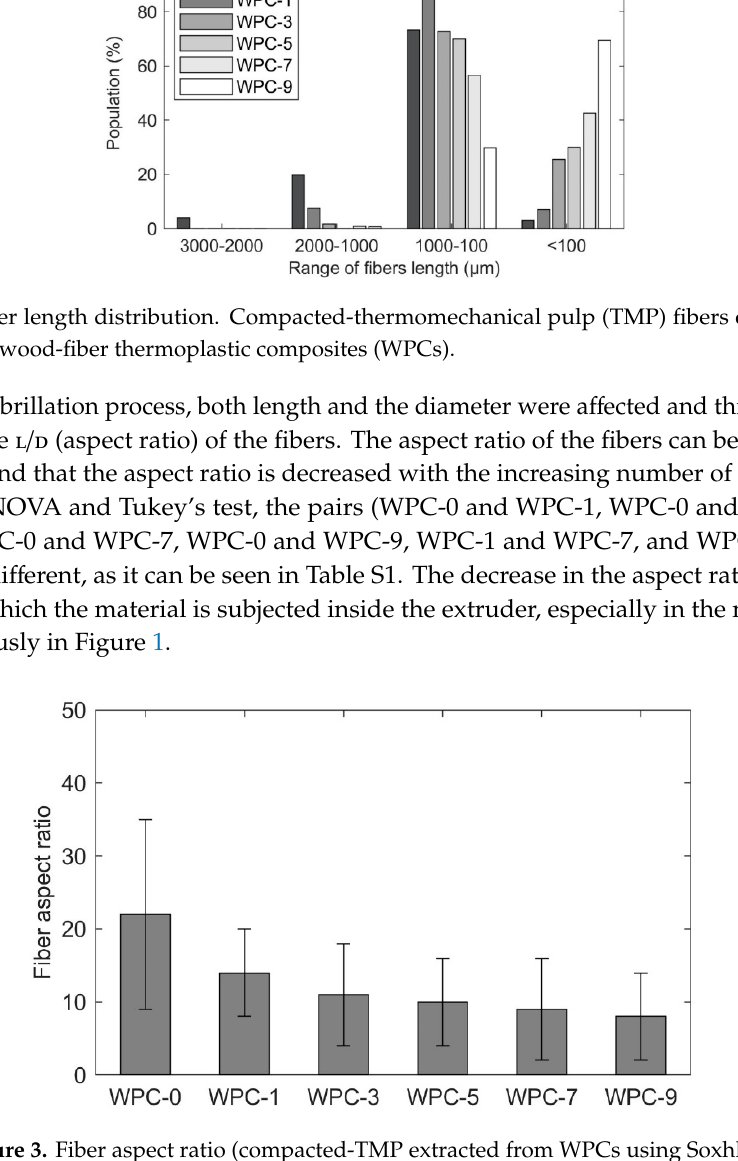
Figure 4. Shear viscosity curves for polypropylene (PP) and WPC before recycling and after recycling at 230 °C.